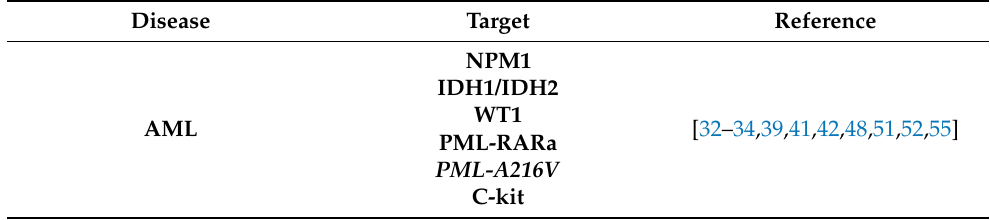
Table 2. ddPCR and myeloid